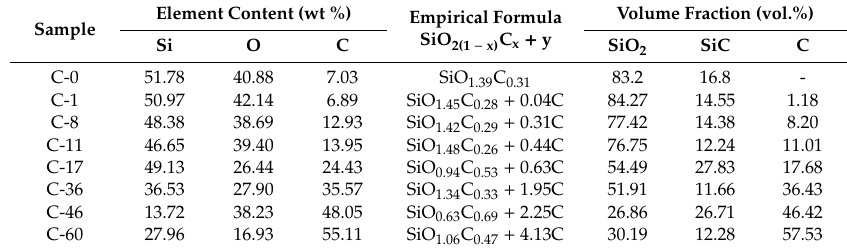
Table 2. Elemental composition, empirical formula and estimated phase composition of selected SiOC / C samples.